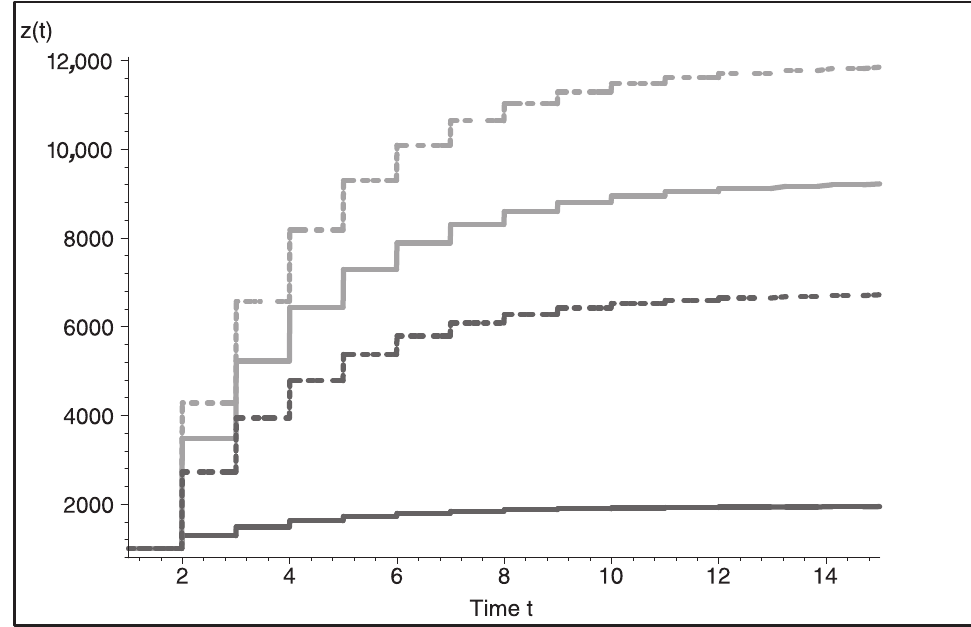
Figure 2. Pollution level: dark—cooperation, light—Nash equilibrium, dotted line—the model without pollution